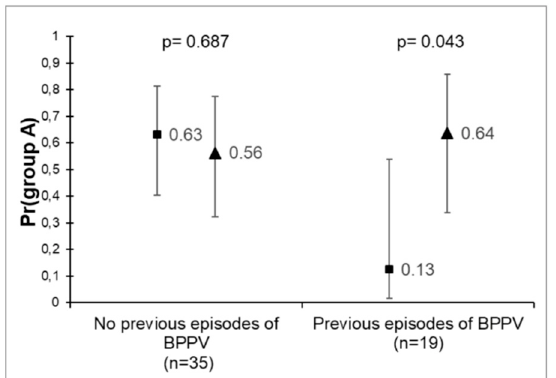
Figure 4. Probability of reaching “ A ” in patients with and without a history of previous episodes of BPPV after the repositioning maneuver